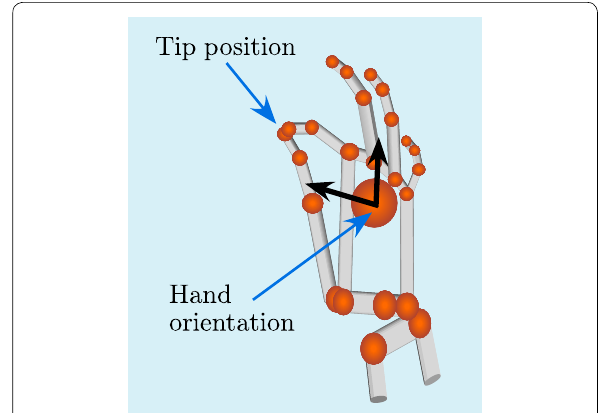
Fig. 3 Skeletal representation of the tracked hand by the Leap Motion Controller. The hand orientation is defined by the normal vec‑ tor to the palm and the direction vector from the palm to the